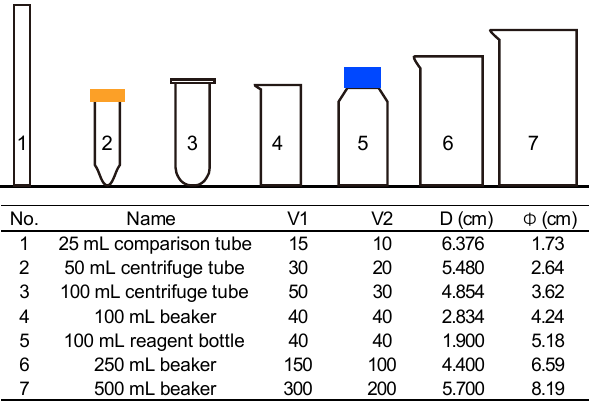
Figure 3. The shape parameters of vessels. V 1 and V 2 means the volume of upper suspension and lower suspension, respectively. D means sinking distance. (cid:56) means average inner diameter, which is calculated by 2 (V 1 /πD) − 2